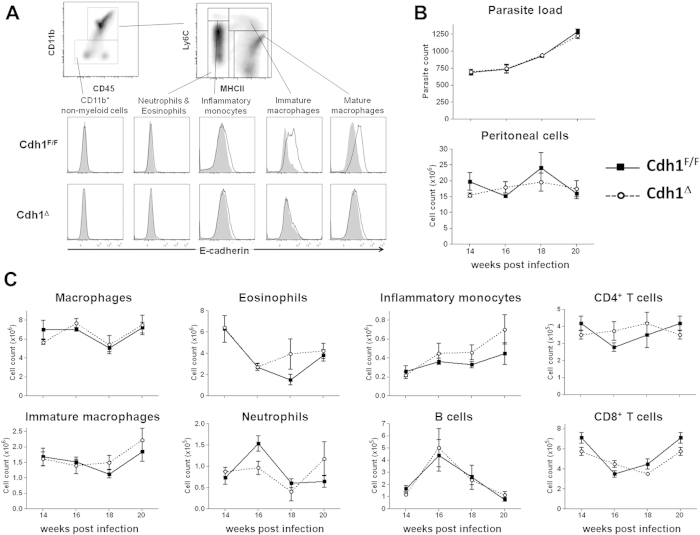
Cdh1Δ mice are equally susceptible to Taenia crassiceps infection.(A) Freshly isolated peritoneal cells from T. crassiceps infected Cdh1F/F and Cdh1Δ mice (14 weeks p.i.) were subjected to multicolour FACS analysis. Myeloid and non-myeloid (G1) cells were first gated based on CD11b expression. Within the CD11b+ myeloid cell gate, Ly6C-MHC II staining discriminates between Ly6Cint/MHC IIneg eosinophils and neutrophils, Ly6Chigh/MHC IIneg inflammatory monocytes, Ly6Chi/MHC IIpos immature macrophages and Ly6Clow/MHC IIhigh mature macrophages. The histograms show an overlay of isotype staining (grey, filled) and anti-E-cadherin staining (bold line) on these gated peritoneal cell types from T. crassiceps infected Cdh1F/F (top) and Cdh1Δ (bottom) mice. (B) Parasite load (top) and total leukocyte cell count (bottom) is similar in the peritoneal cavities of Cdh1Δ and Cdh1F/F infected mice at all indicated time points. (C) Peritoneal cells from T. crassiceps infected Cdh1F/F and Cdh1Δ mice were isolated at indicated time point and subjected to multicolour FACS analysis and all leukocyte populations were gated as shown in Figure S2. The absolute number of macrophages, eosinophils, inflammatory monocytes, immature macrophages, neutrophils, B cells and CD4+ and CD8+ T cells in the peritoneal cavities of T. crassiceps infected Cdh1F/F and Cdh1Δ mice (average ± SEM of 5 mice per group per time point) is shown.